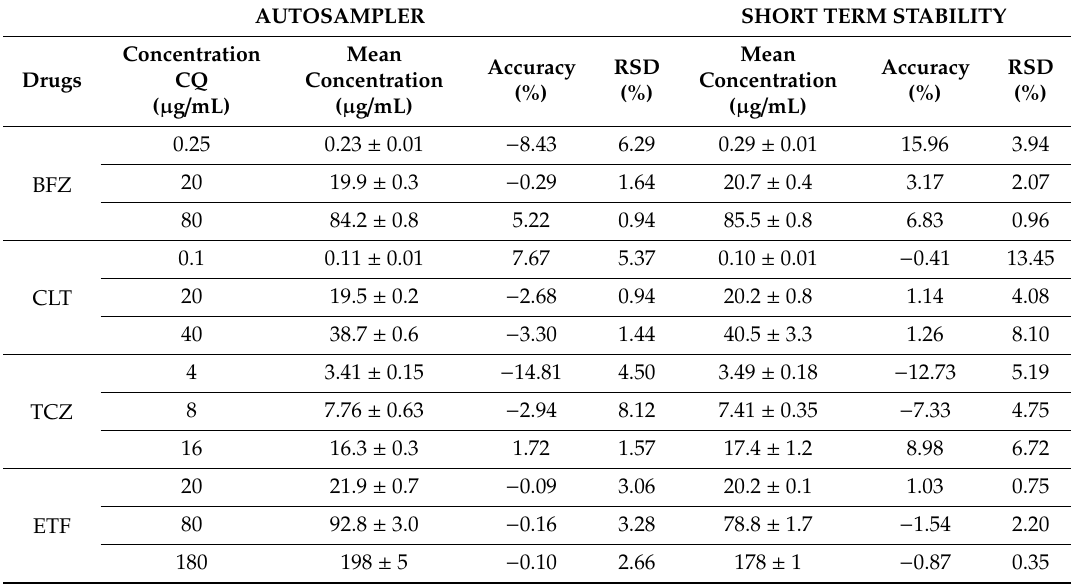
Table 10. Autosampler and short-term stability of quality control (QC). Results are expressed as mean ± SD (n =